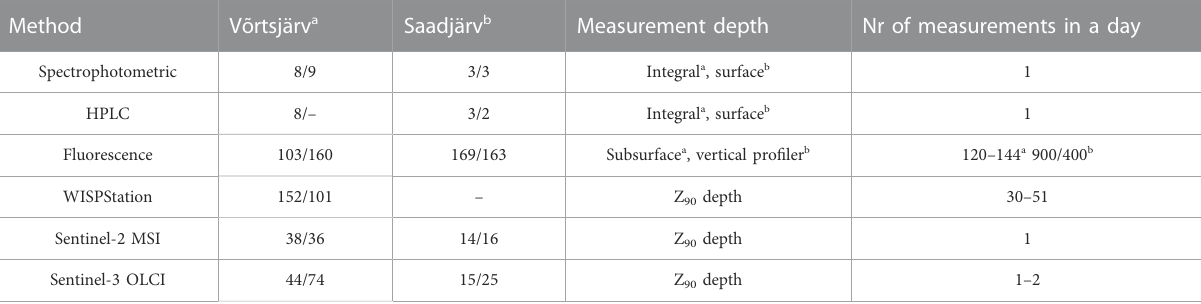
TABLE 3 Number of days with data used in this study. Slash (/) separates observations from years 2018 and